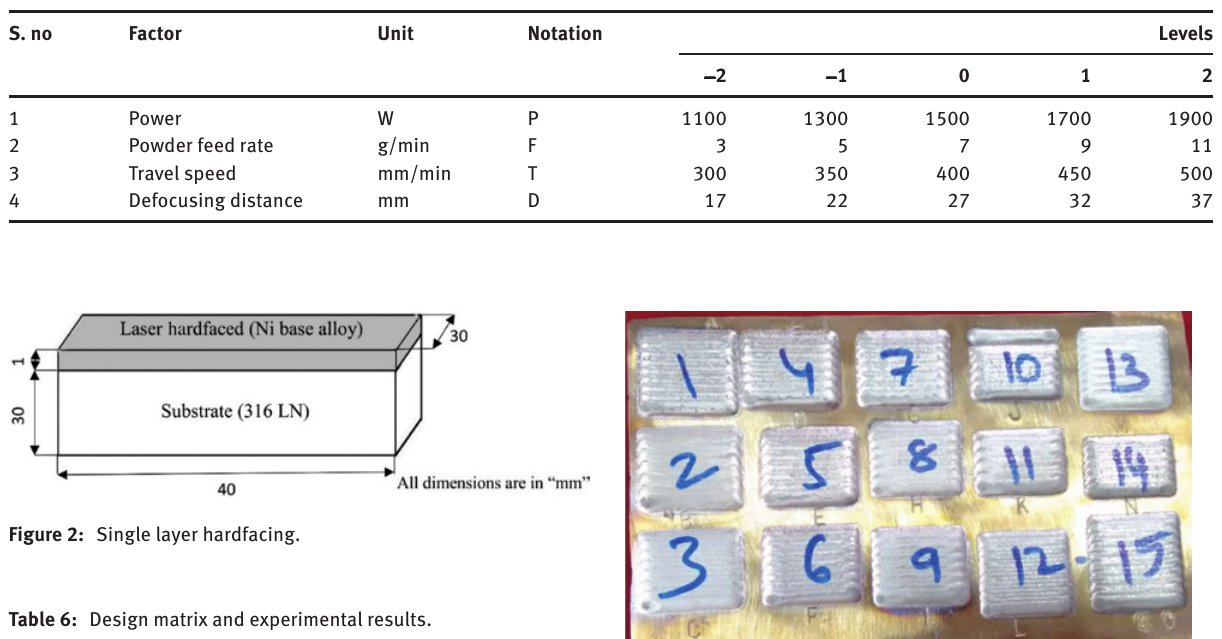
Table 5: LH process parameters and their working range.